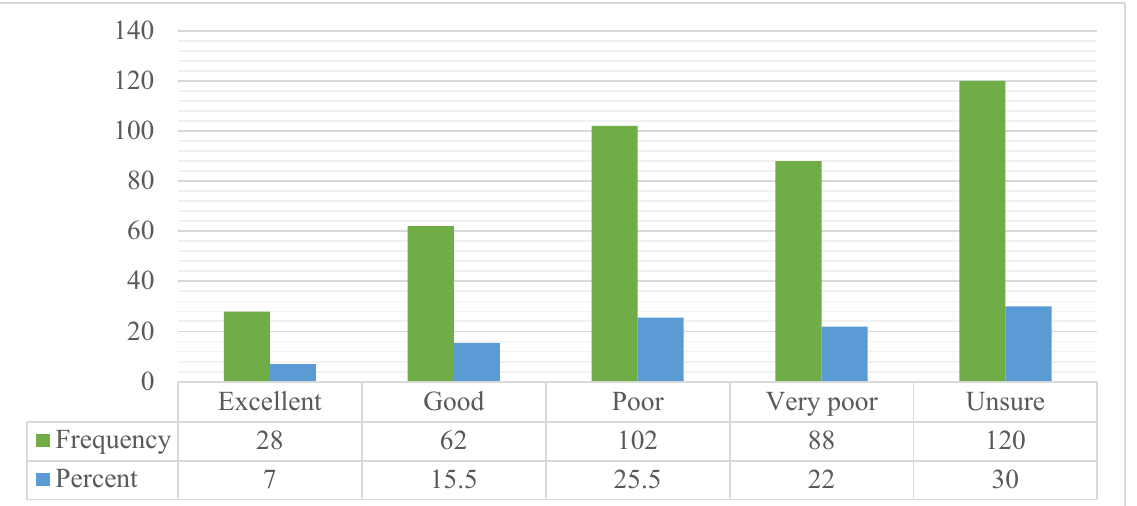
Figure 2: The Level of Community Participation based on the Mechanisms below.